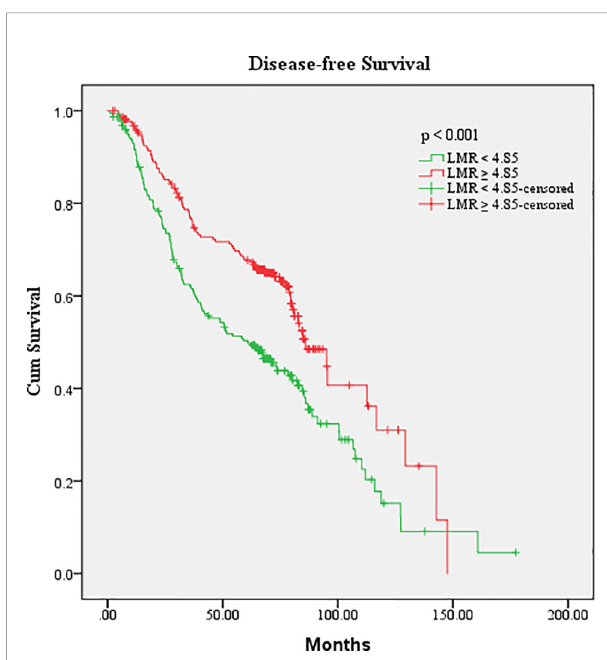
FIGURE 1 | Kaplan – Meier estimates of the DFS of breast cancer patients according to the LMR level in overall